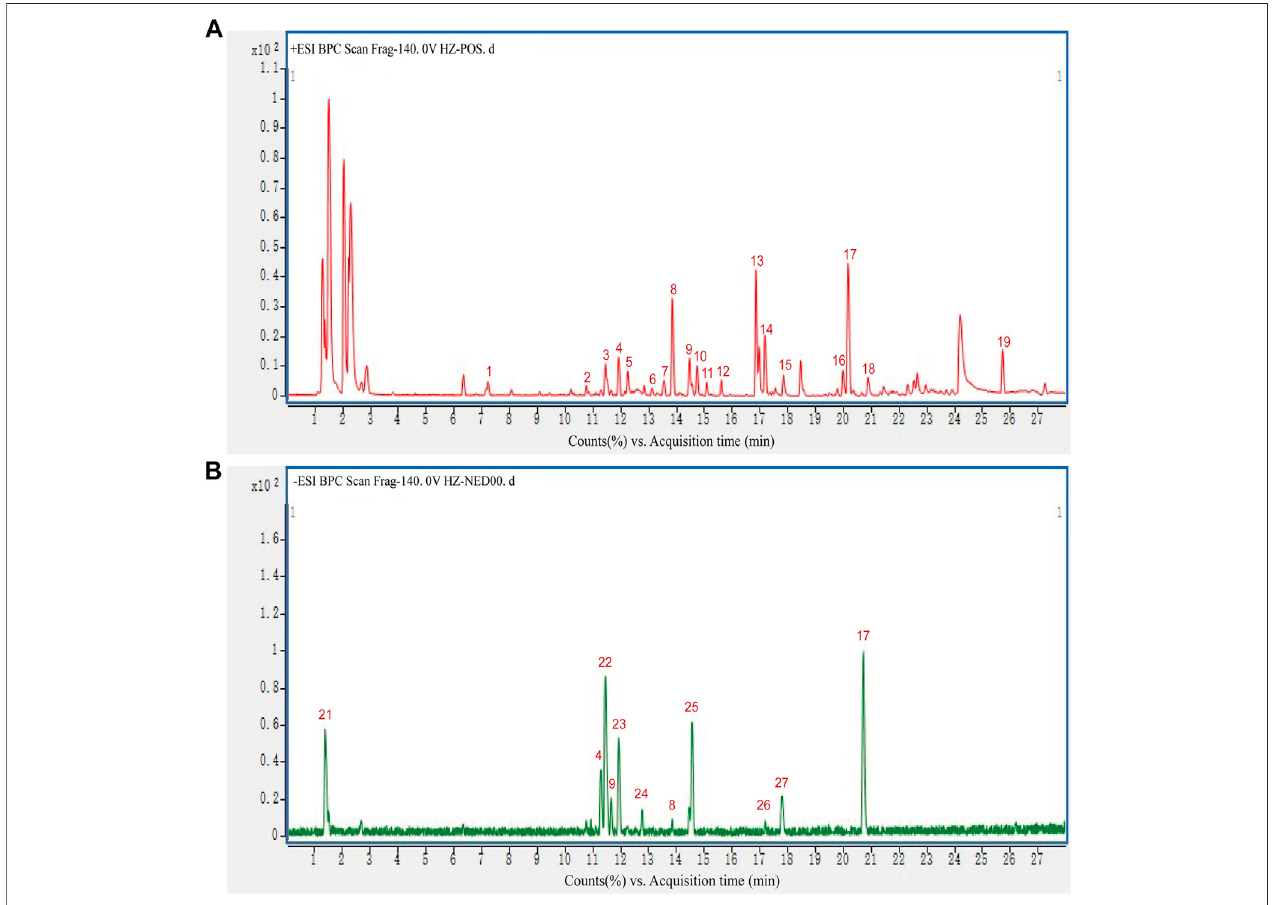
FIGURE 1 | HPLC-Q-TOF-MS chromatogram of 27 constituents in positive and negative mode.